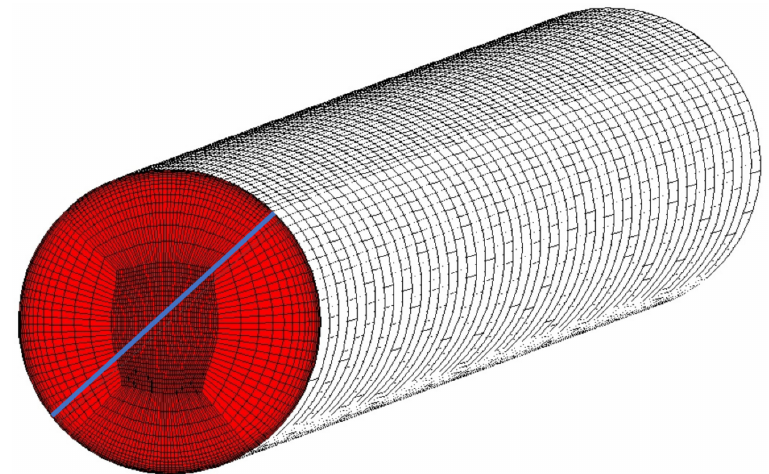
Figure 13. First cooling hole discretization with the linear section.